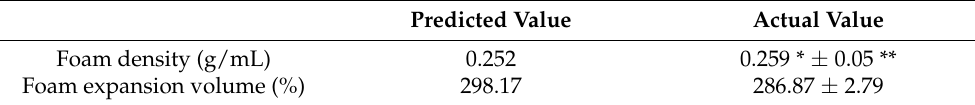
Table 5. Predicted and actual value of responses from optimal